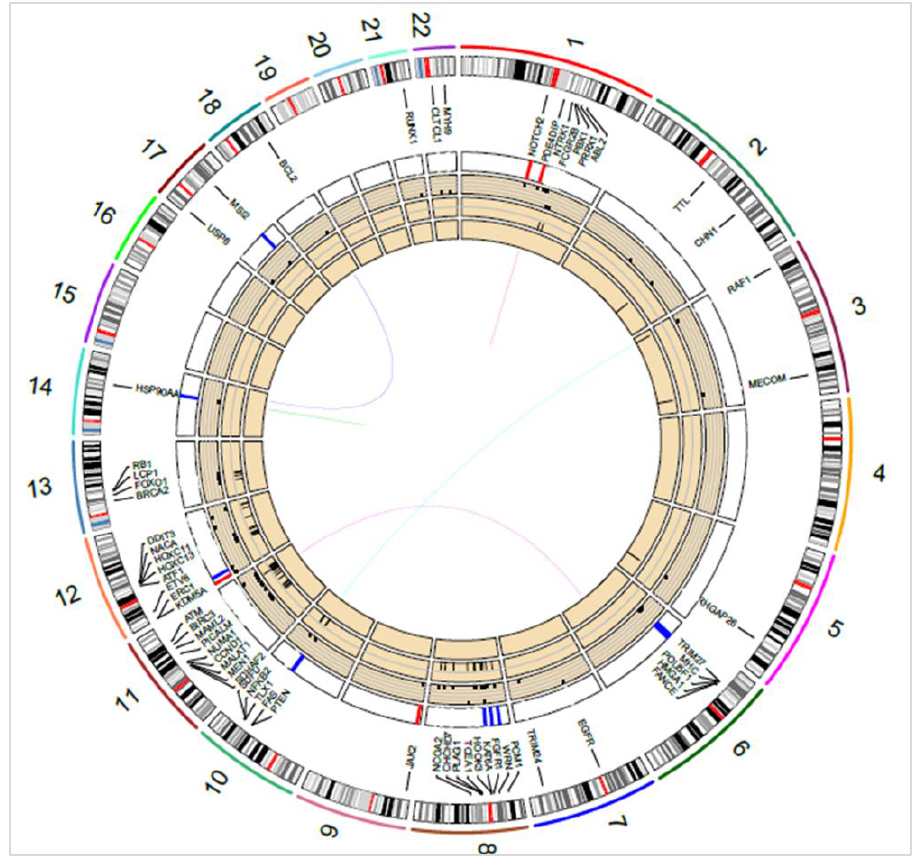
Figure 5. Circos diagram showing key oncogenes and tumor suppressor genes overlapping SSVs, CNVs, and SVs in the OCI-LY1 cell line. Translocations/fusions are shown by connecting lines, inner-to-outer circles: MEIs, INVs, SSVs (dots), and CNVs (red and blue bars). Chromosome numbers 1-22 are indicated next to the outermost circle. Table 3. Probable subgroups within and between DLBCL subtypes observed in cell lines based on shared genetic variations.